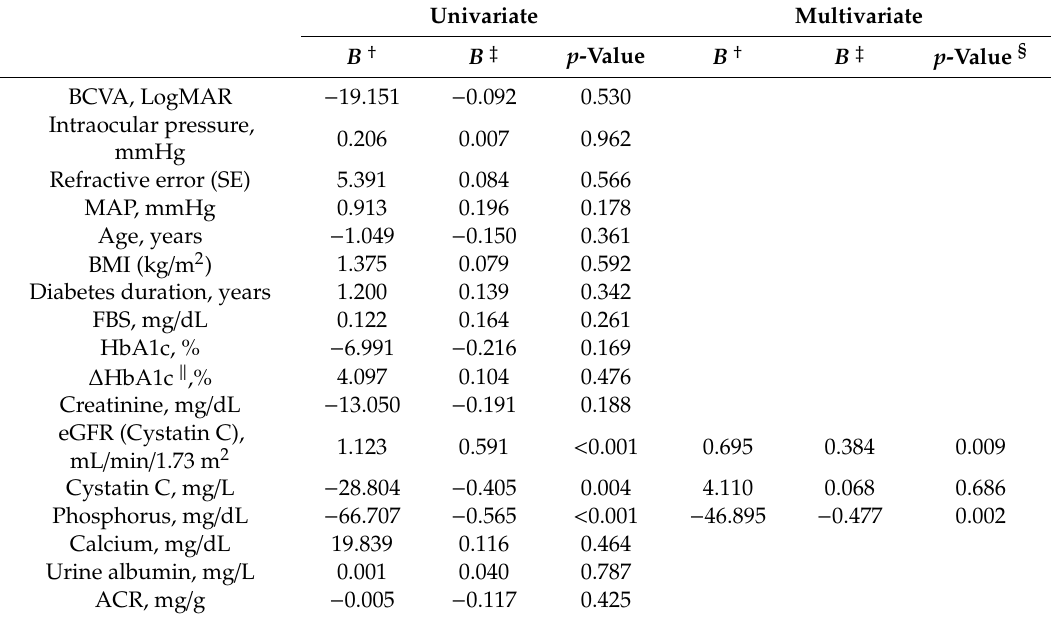
Table 3. Univariate and multivariate linear regression analyses of the association between subfoveal choroidal thickness and chronic kidney disease parameters.